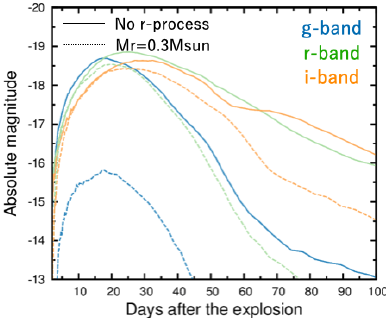
Figure 1. The bolometric luminosities of SNe with di ff erent r-process masses.